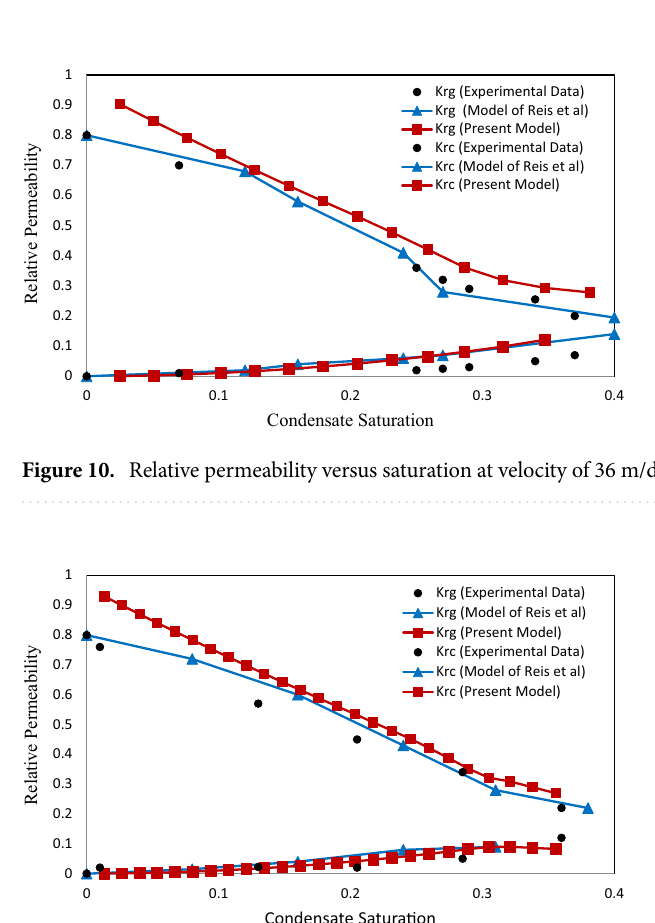
Figure 9. Relative permeability versus saturation at velocity of 18 m/day and IFT = 0.037 mN/m.